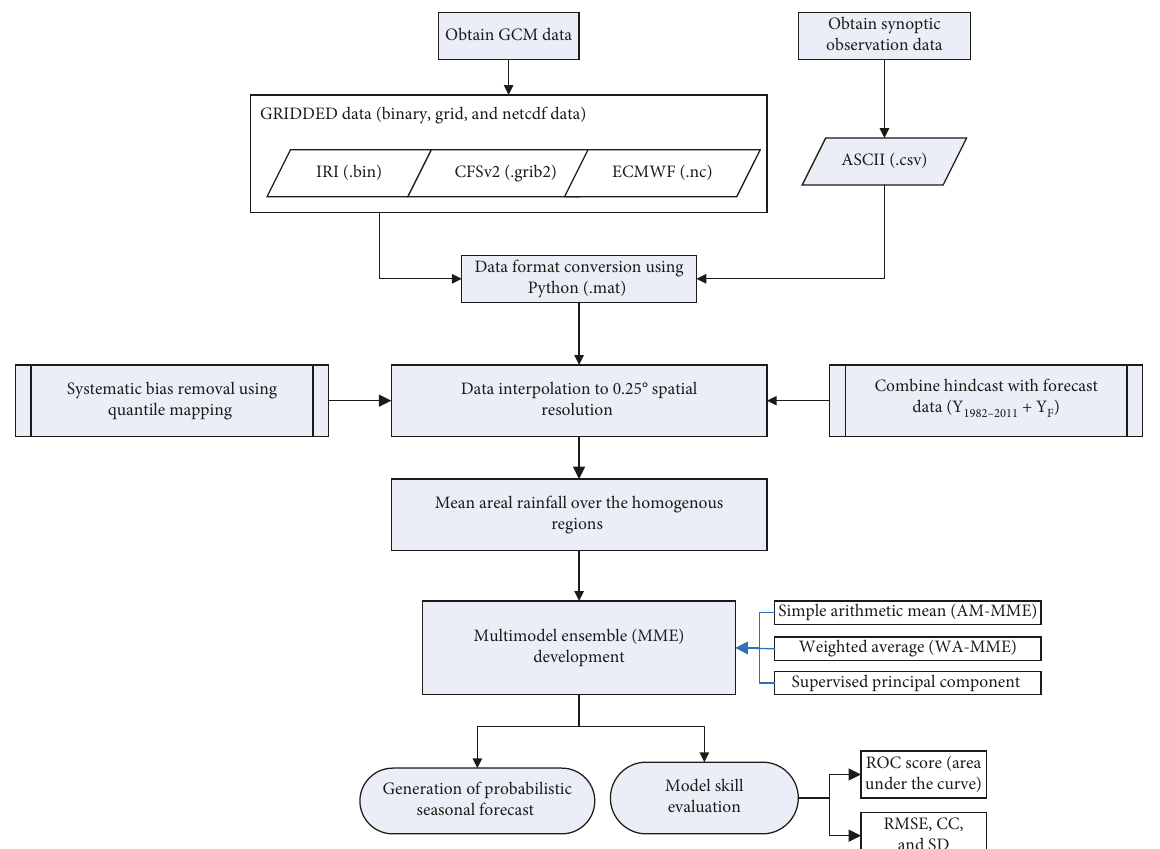
Figure 3: Simplified methodology for the model development and forecast customization and generation of MME-based seasonal probabilistic forecast along with model skill